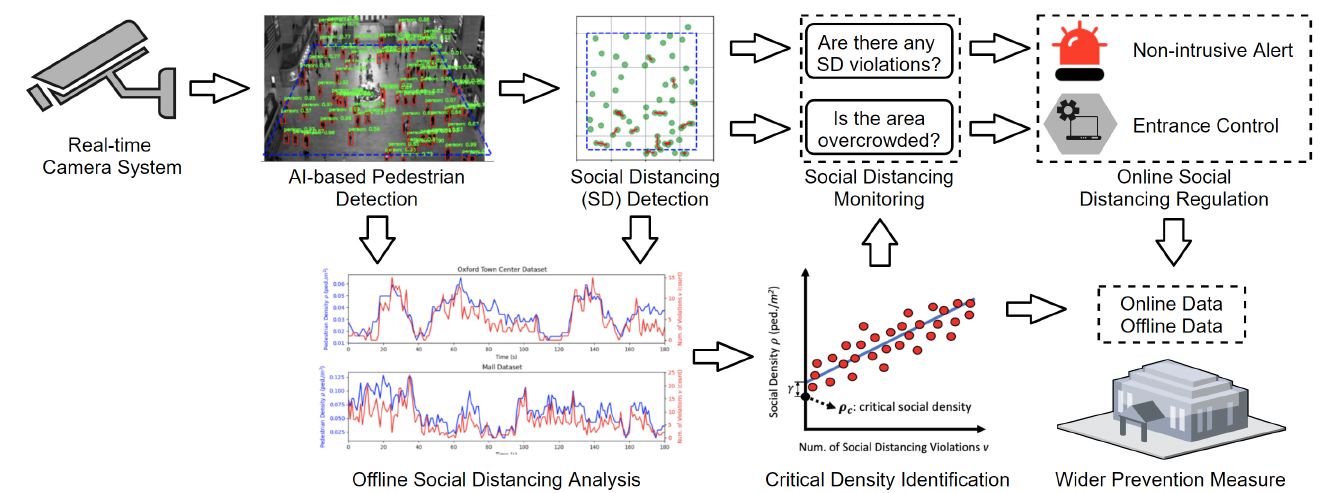
Figure 1. Overview of the proposed system. An audio-visual cue is emitted each time an individual breach of social distancing is detected. We also make a novel contribution by defining a critical social density value ρ c for measuring overcrowding. Entrance into the region-of-interest can be modulated online with this value. The aggregated non-personal data can also be analyzed offline to provide more insights into the social distancing practice in different public areas. Based on both online and offline data, wider prevention measures can be taken as quickly as possible when necessary. Our system is real-time and does not record